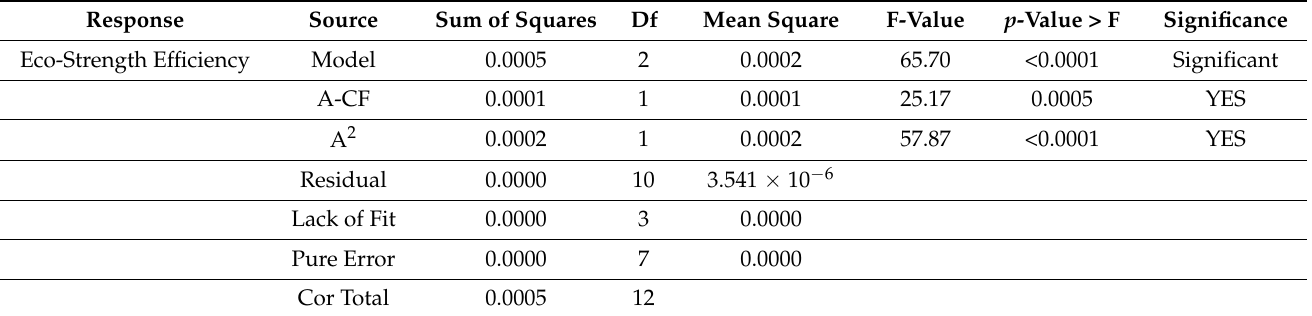
Table 11. ANOVA Results for the Variable Response 28-day Eco-Strength